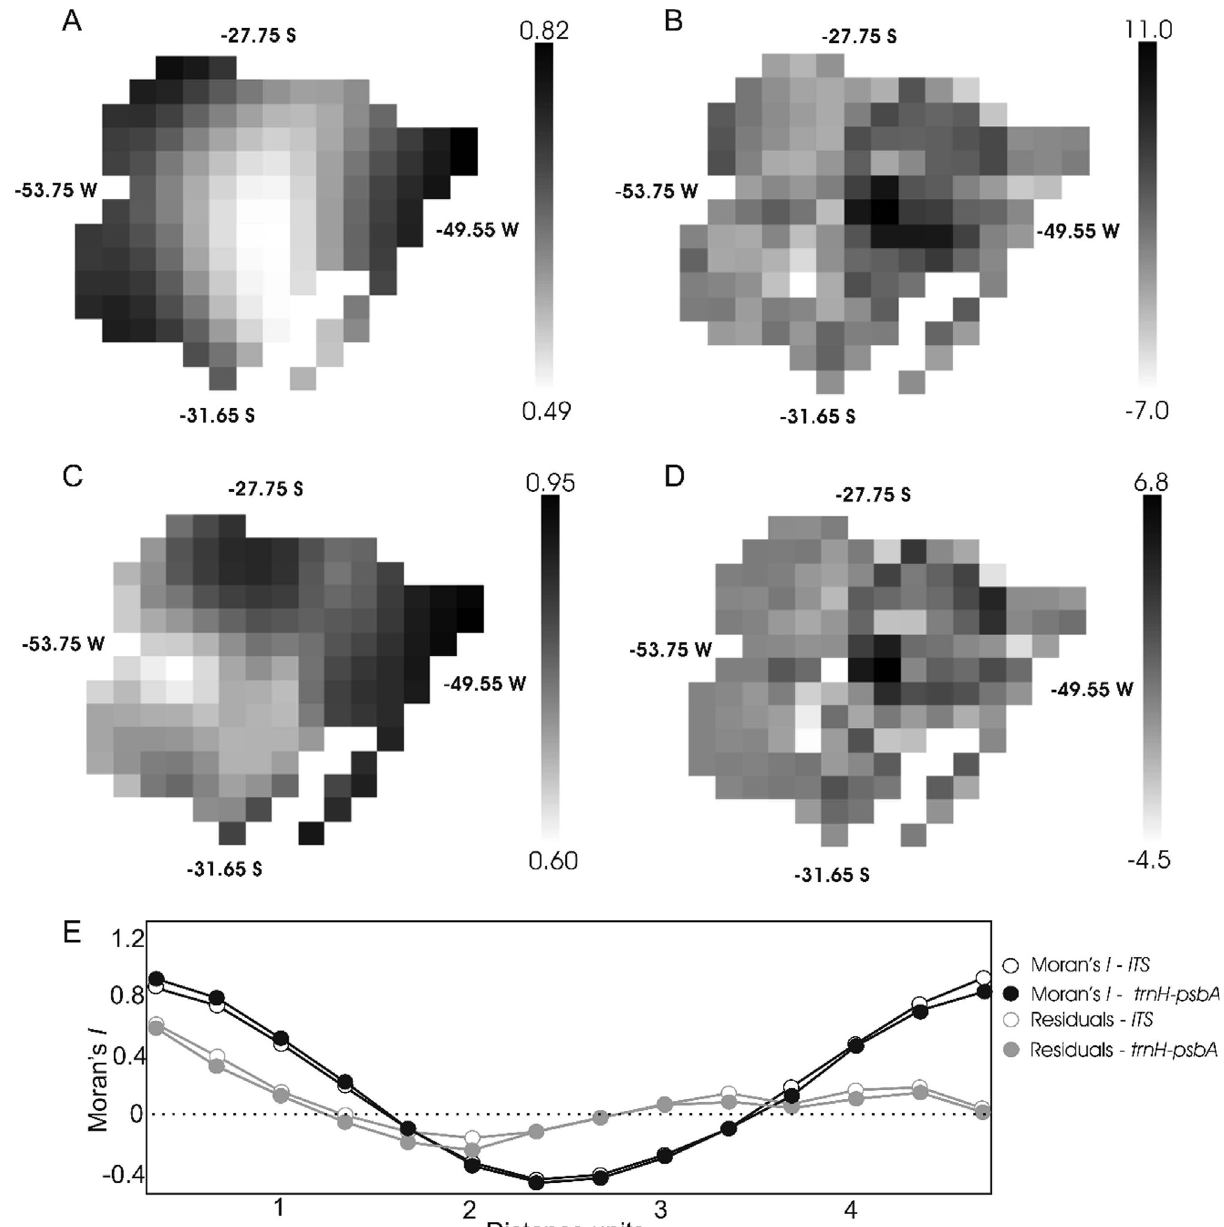
Figure2 -Geographicallyweightedregression.Thevaluesofgeneticdiversitywereregionallyregressedagainstthemostrelevantbioclimaticpredictors identified in SAR models (Table 3) in addition to altitude to minimize residuals. The ITS marker exhibited higher local R 2 values in eastern and western areas(A),andthehighestvaluesofresidualswereminimizedintheseareas(B).Thelocal R 2 for trnH - psbA arelowerinthecentralarea(C),withapattern of residual values similar to that observed for ITS (D). All analyses were significant (p < 0.001). The Moran’s I correlogram (E) shows that these similari- ties in correlation and residuals are both also found in distinct distance